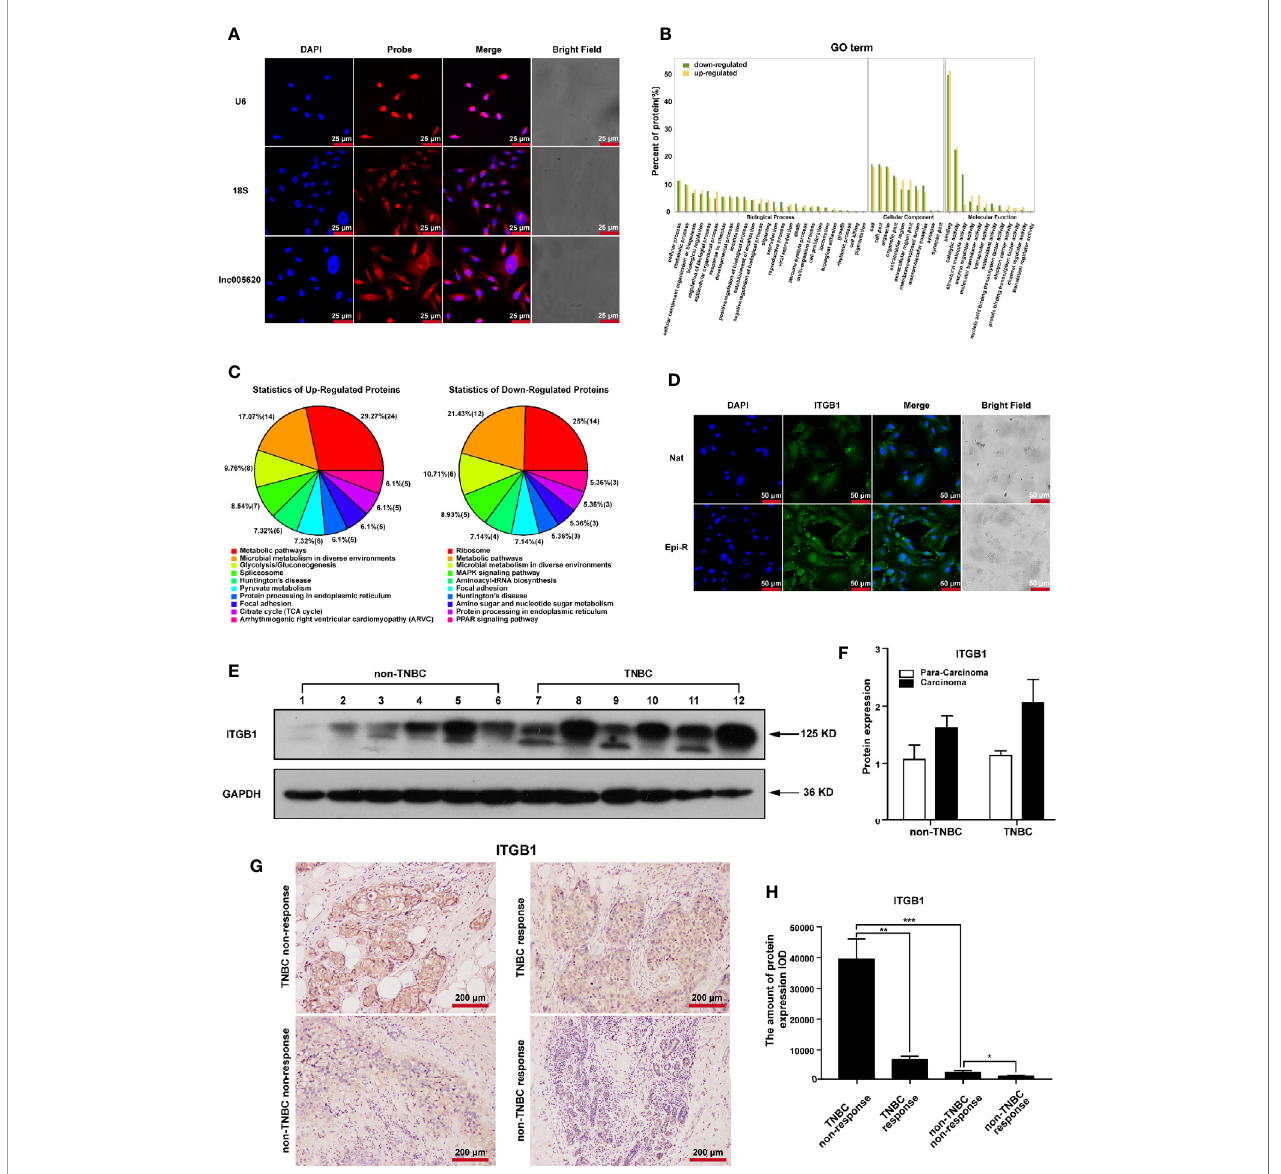
FIGURE 5 | Identi fi cation of key proteins associated with epirubicin resistance in MDA-MB-231 cells. Epirubicin-resistant (Epi-R) and native (Nat) MDA-MB-231 cells were used for iTRAQ proteome analysis. (A) FISH analysis of the subcellular location of lnc005620 with a speci fi c probe in native MDA-MB-231 cells. Small nuclear RNA U6 (U6) and 18S ribosomal RNA (18S) served as references for nuclear and cytoplasmic localization, respectively. Blue: DAPI for nuclei, red: probe for target genes. Scale bars: 25 m m. n = 3. (B) GO function analysis of 202 differentially expressed proteins between Epi-R and Nat cells. (C) KEGG analysis of 202 differentially expressed proteins between Epi-R and Nat cells. (D) Immuno fl uorescence staining of ITGB1 in Epi-R and Nat cells. Blue: DAPI for nuclei, green: ITGB1. Scale bars: 50 m m. n = 3. (E) Western blotting of ITGB1 in breast cancer tissues and paired adjacent non ‐ tumor tissues from TNBC and non-TNBC patients. Glyceraldehyde 3-phosphate dehydrogenase (GAPDH) was used as an internal reference. Lines 1, 3, 5, 7, 9, 11: para-carcinoma tissues; lines 2, 4, 6, 8, 10, 12: carcinoma tissues. (F) Quantitative analysis of ITGB1 protein expression. (G) Immunohistochemistry analysis of ITGB1 expression in breast cancer tissues from TNBC and non-TNBC patients responding or nonresponding to epirubicin treatment. Scale bars: 200 m m. n = 3/group. (H) Quantitative analysis of ITGB1 expression. Data are represented as the mean ± SD, * P < 0.05, ** P < 0.01, *** P <